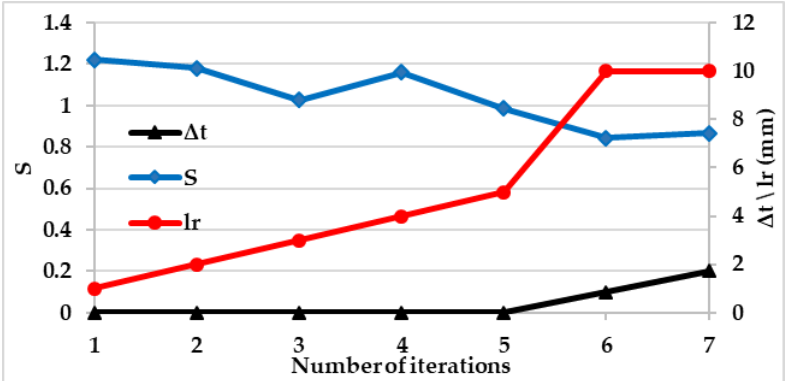
Figure 19. Iteration process of the optimization algorithm for magnetic core used in a circular coupler.